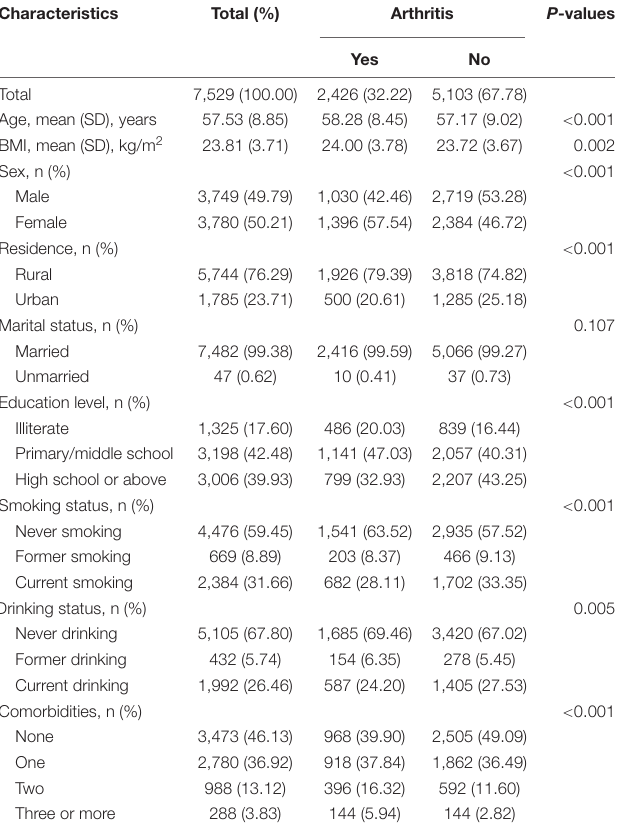
TABLE 2 | Associations between baseline arthritis and subsequent cognitive